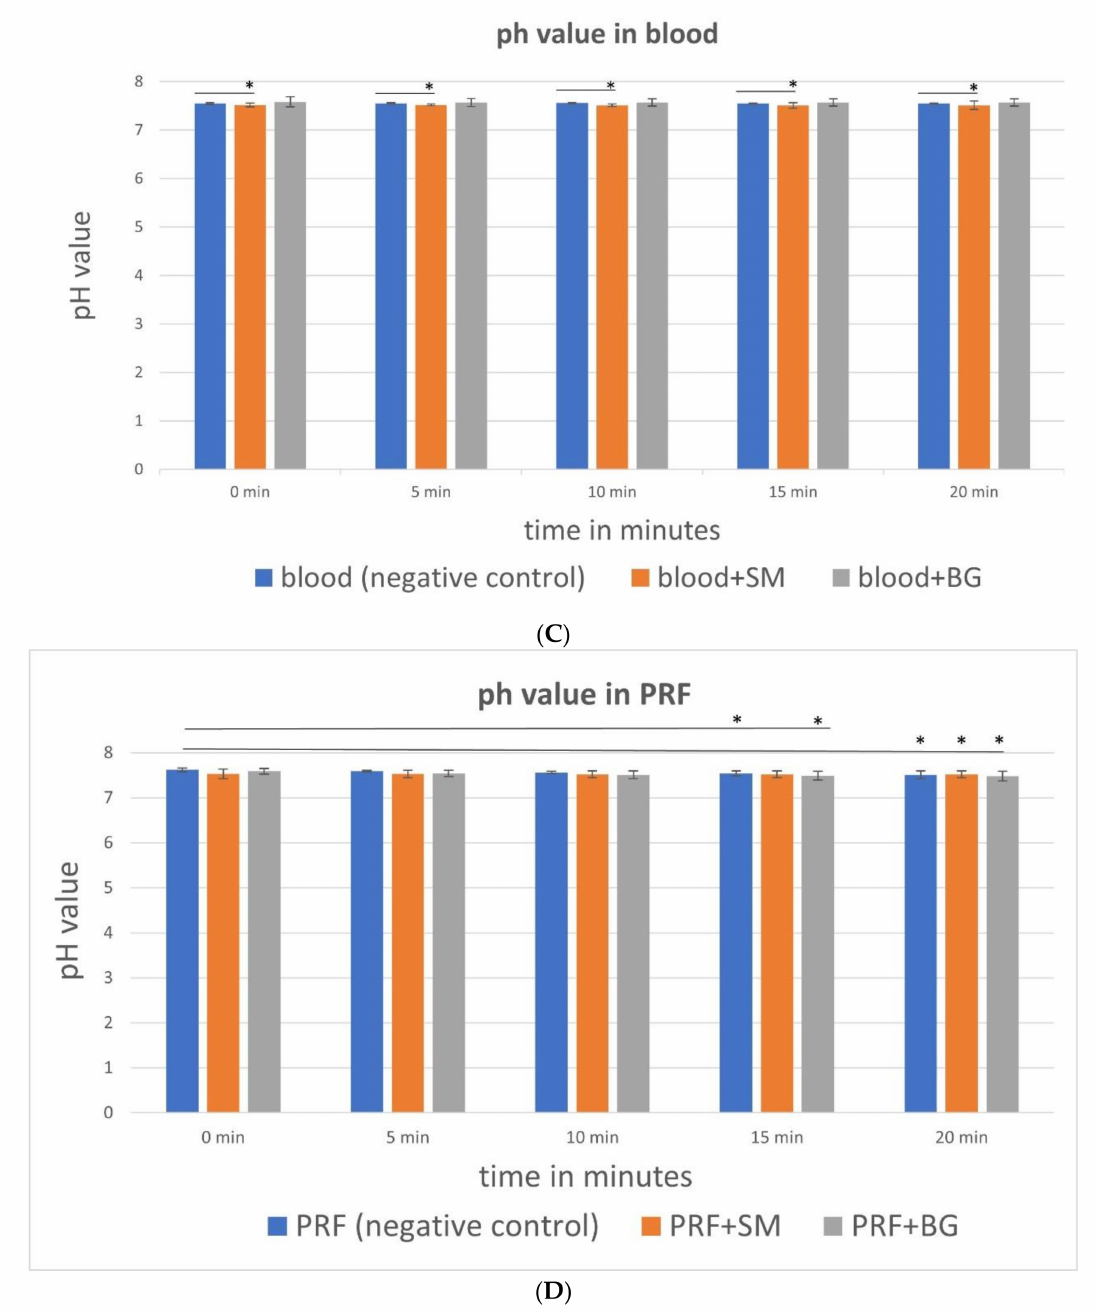
Figure 4. Differences in pH value during 20 min of rehydration of the respective CM depending on the media: ( A ) saline solution, ( B ) ph 7 solution, ( C ) blood, ( D ) PRF. Blue column: negative control media, orange column: media plus Symbios ® (_S), grey column: media plus Bio-Gide ® (_B). * marks statistically significant differences ( p < 0.05; for details, please see the responding